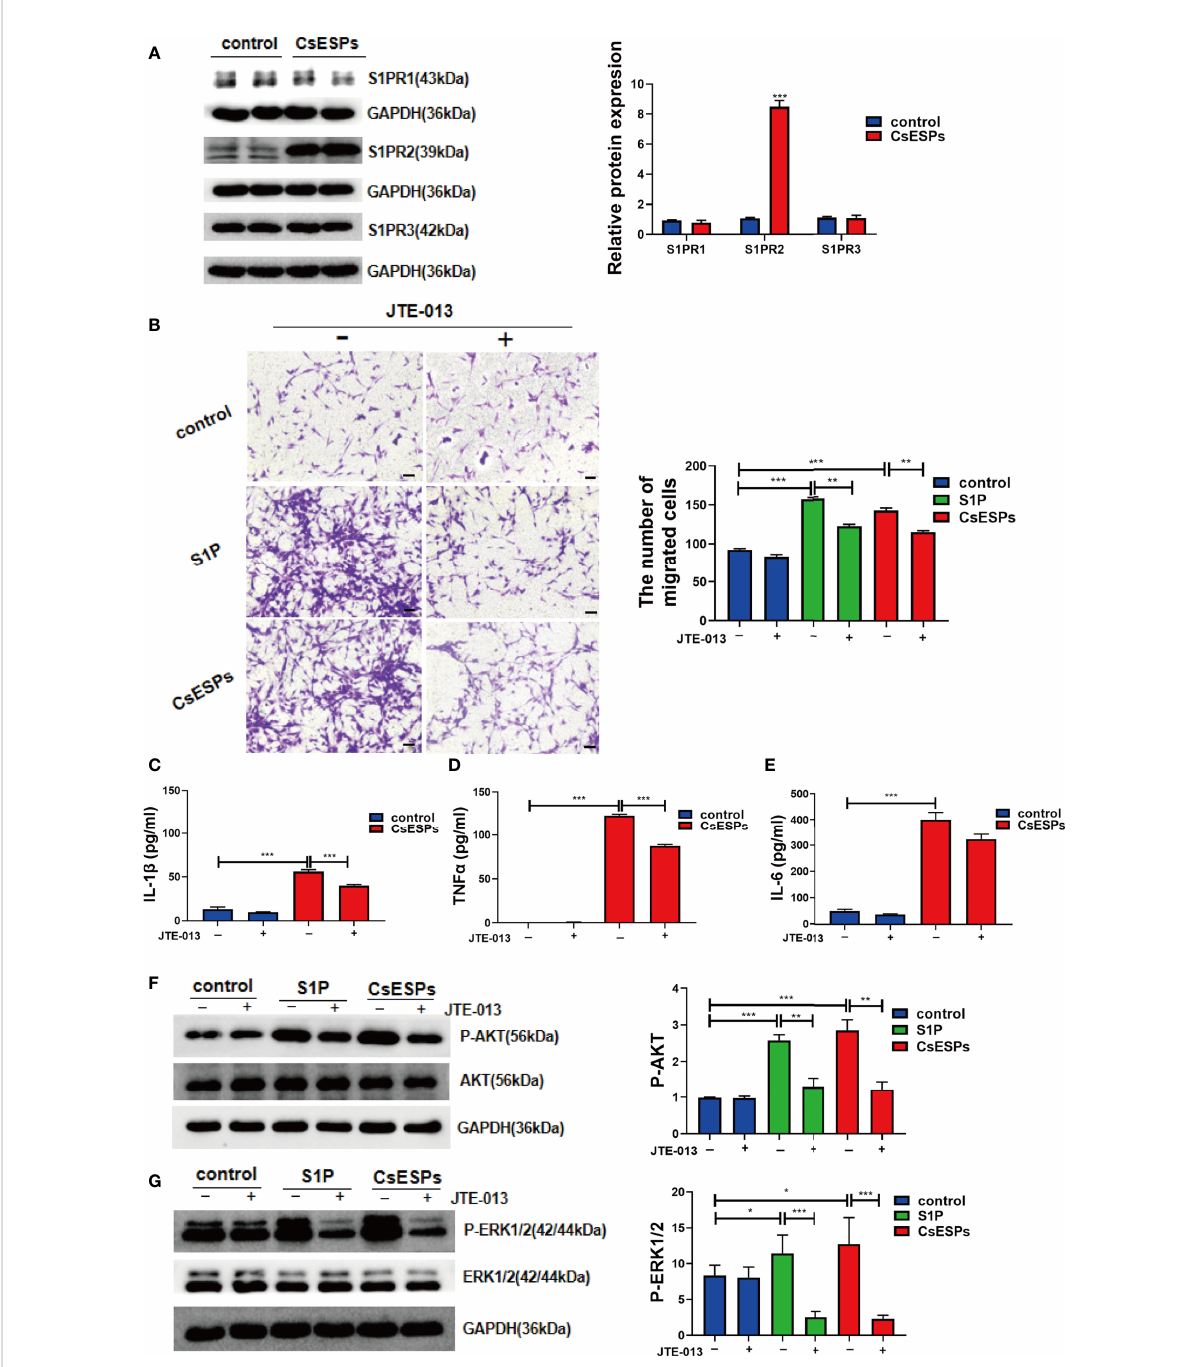
FIGURE 8 Role of S1PR2 played in CsESPs -induced migration and pro-in fl ammatory cytokines production of BECs. (A) After CsESPs stimulation, the protein levels of S1PR1, S1PR2, and S1PR3 were detected by western blotting. (B) Effect of JTE-013 on CsESPs/S1P-induced cell migrated in cultured BECs by transwell assay. (C-E) Measurement of the pro-in fl ammatory cytokines IL-1 b , TNF a , and IL-6 the relative protein expression by ELISA in in the BECs culture supernatant. (F, G) BECs were pretreated with JTE-013 (10 m M) for 30 minutes, then treated with vehicle control (DMSO), CsESPs (60ug/ml), or S1P (100nM). Protein levels of P -AKT, AKT, P-ERK1/2, and ERK1/2 were determined by western blotting. Compared with indicated groups, * P <0.05, ** P <0.01, *** P